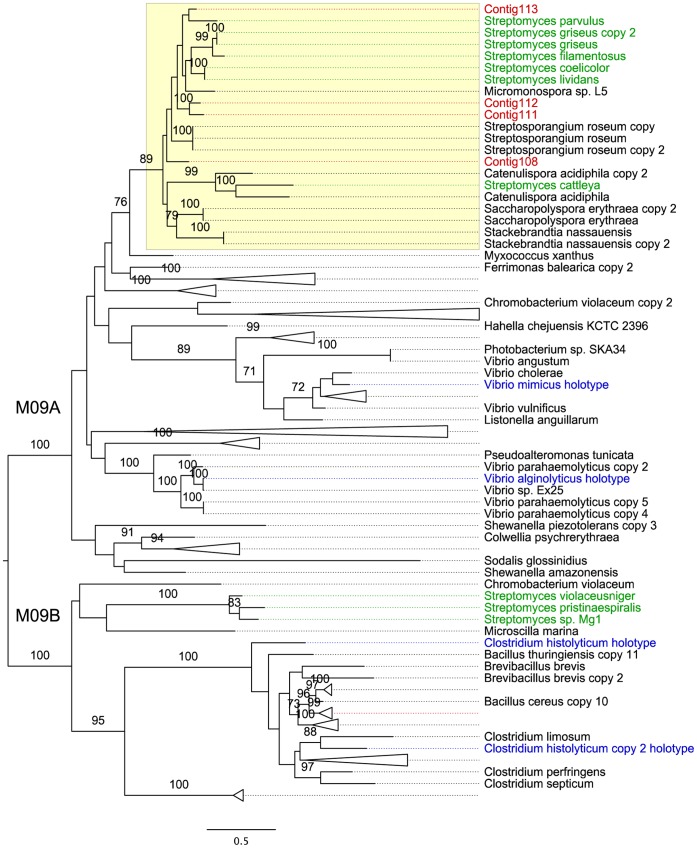
Phylogeny of microbial collagenases.Collagenase consensus sequences are coloured in red (Contigs 108, 111–113). The actinobacterial clade is highlighted in yellow and subfamilies M09A and B are indicated. The Streptomyces reference sequences from the MEROPS M09 family are shown in green and the family holotypes in blue. MEROPS references displayed with species names and (arbitrary) collagenase copy number. The phylogeny was inferred using the maximum likelihood method. Numbers refer to bootstrap support values higher than 75%.